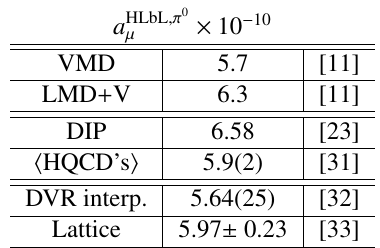
Table 2. Values of the one-pion exchange obtained